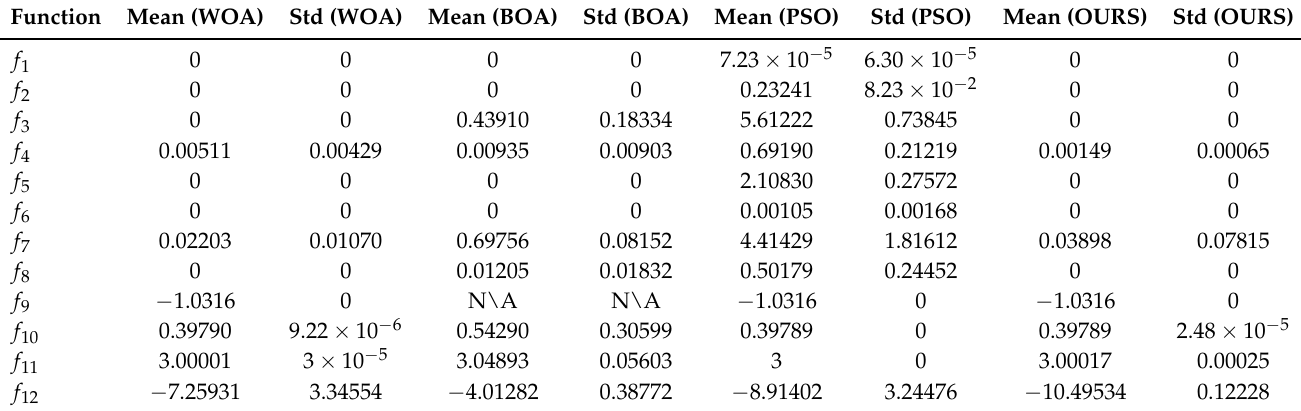
Table 2. Compare the mean and variance of different algorithms through benchmark